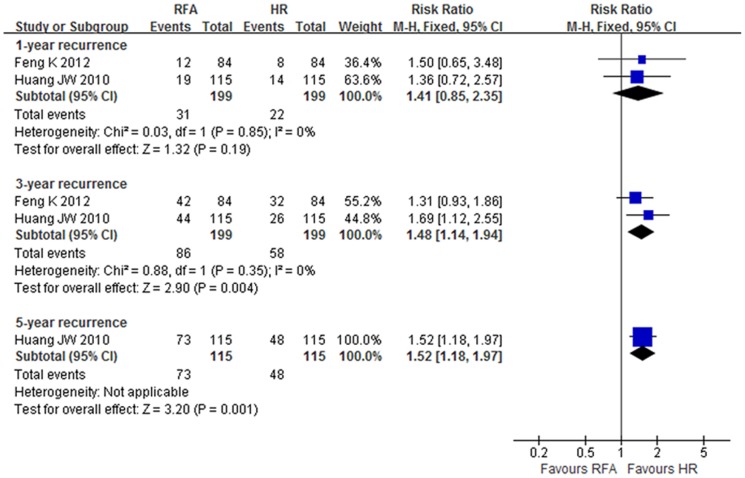
Recurrence rate at 1-, 3- and 5-year in RCTs.